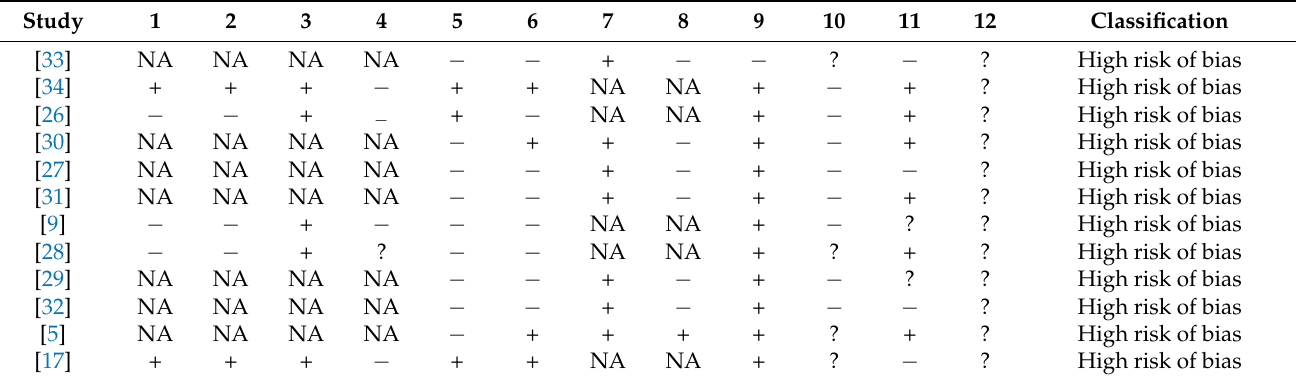
Table 4. Quality appraisal for each included